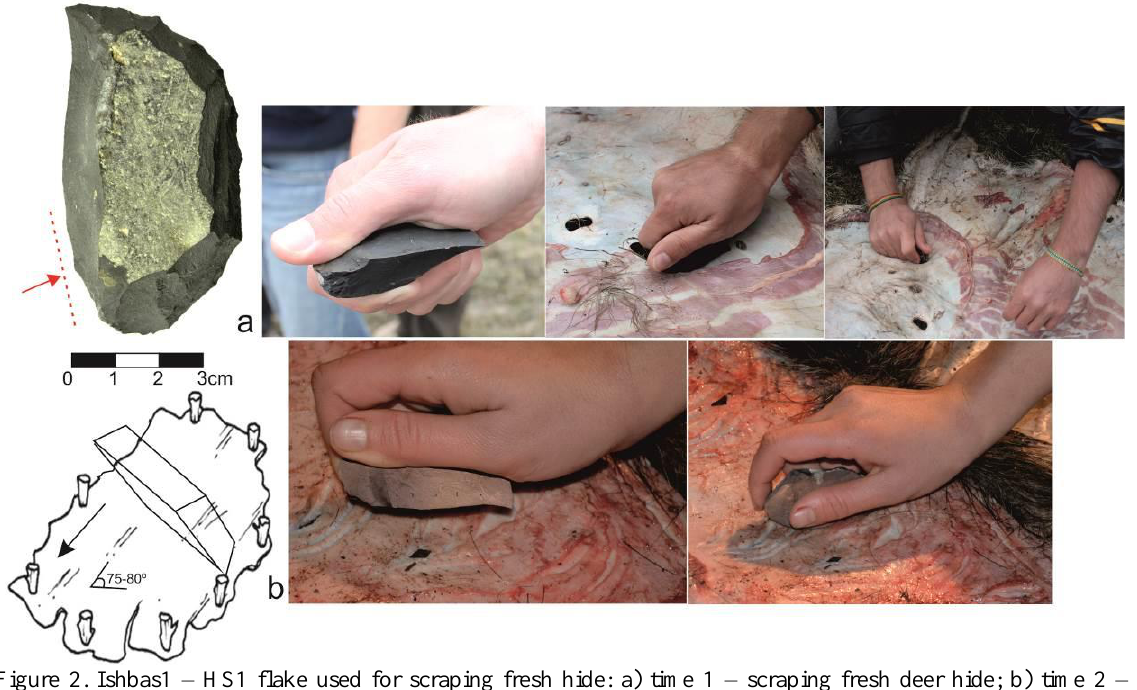
Figure 2. Ishbas1 – HS1 flake used for scraping fresh hide: a) time 1 – scraping fresh deer hide; b) time 2 – scraping fresh wild boar hide. Dashed line on left lateral indicates the most active area of the edge. Arrow indicates direction of tool movement. The illustration below shows direction of movement and the working